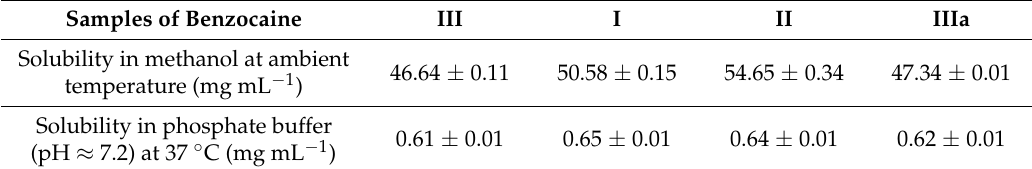
Table 4. Solubility of polymorphic forms of benzocaine.